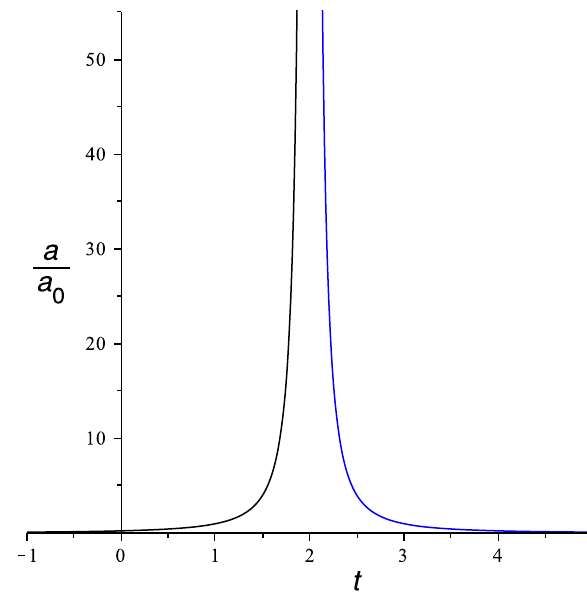
Fig. 1 The scale factors of an expanding universe approaching the Big Rip and of a contracting universe emerging from it, for equation of state parameter w = − 5 / 3 and t 0 = 2 in arbitrary